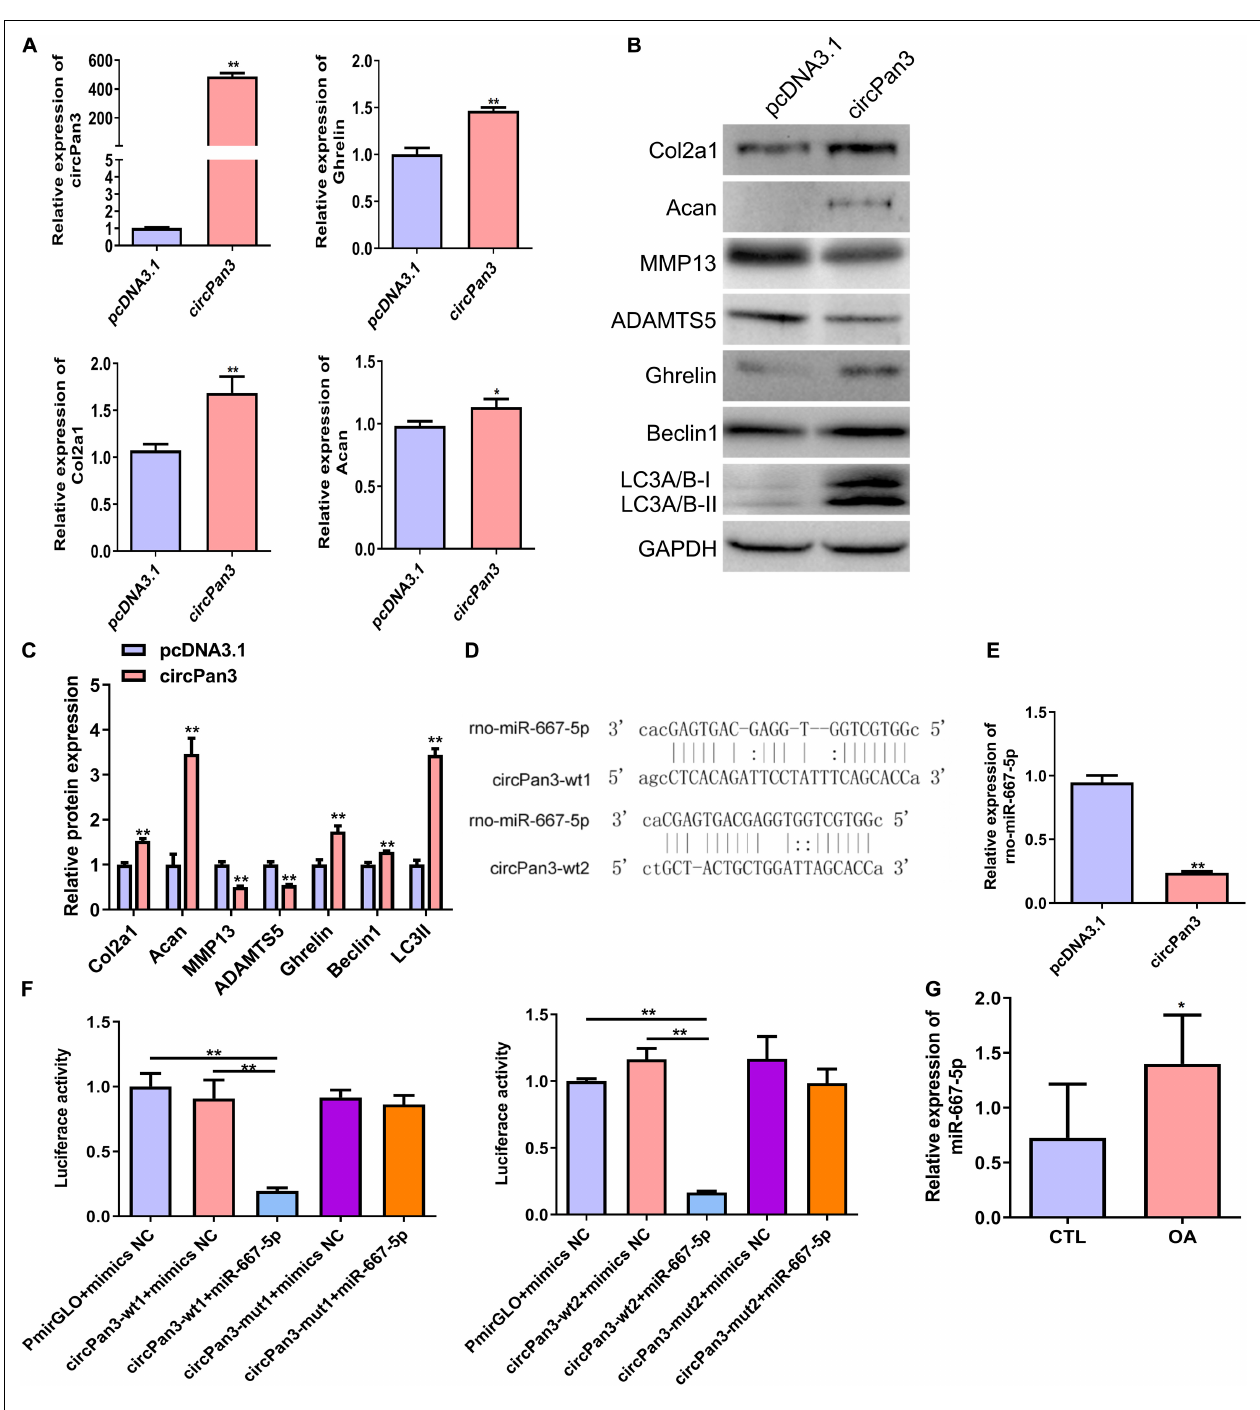
FIGURE 5 | CircPan3 directly target miR-667-5p and promoted ghrelin synthesis and chondrocyte autophagy. (A) Relative expression levels of circPan3, ghrelin, Col2a1, and Acan in rat chondrocytes with or without overexpressing circPan3. Expression levels of circRNAs and the indicated mRNAs were assessed by RT–qPCR. (B) Western blotting results of Col2a1, Acan, MMP13, ADAMTS5, ghrelin, beclin 1, and LC3 in rat chondrocytes with or without overexpressing circPan3. (C) Quantitative analysis of western blotting in (B) . (D) Two binding sites of circPan3 to miR-667-5p were predicted by bioinformatics analysis. (E) Relative expression levels of miR-667-5p in rat chondrocytes with or without overexpressing circPan3. The miR-667-5p expression was assessed by RT–qPCR. (F) Validation of the direct binding between circPan3 and miR-667-5p in rat chondrocytes by dual luciferase reporter assay. (G) The miR-667-5p expression in cartilage tissues of rats from CTL and OA group was determined by RT-qPCR. RT–qPCR, quantitative real-time polymerase chain reaction; Col2a1, collagen 2a1; Acan, aggrecan; MMP13, matrix metallopeptidase 13; ADAMTS5, ADAM metallopeptidase with thrombospondin type 1 motif 5; GAPDH, glyceraldehyde-3-phosphate dehydrogenase; wt, wild type; mut, mutant; CTL, control; OA, osteoarthritis. * P < 0.05; ** P < 0.01, n = 3.